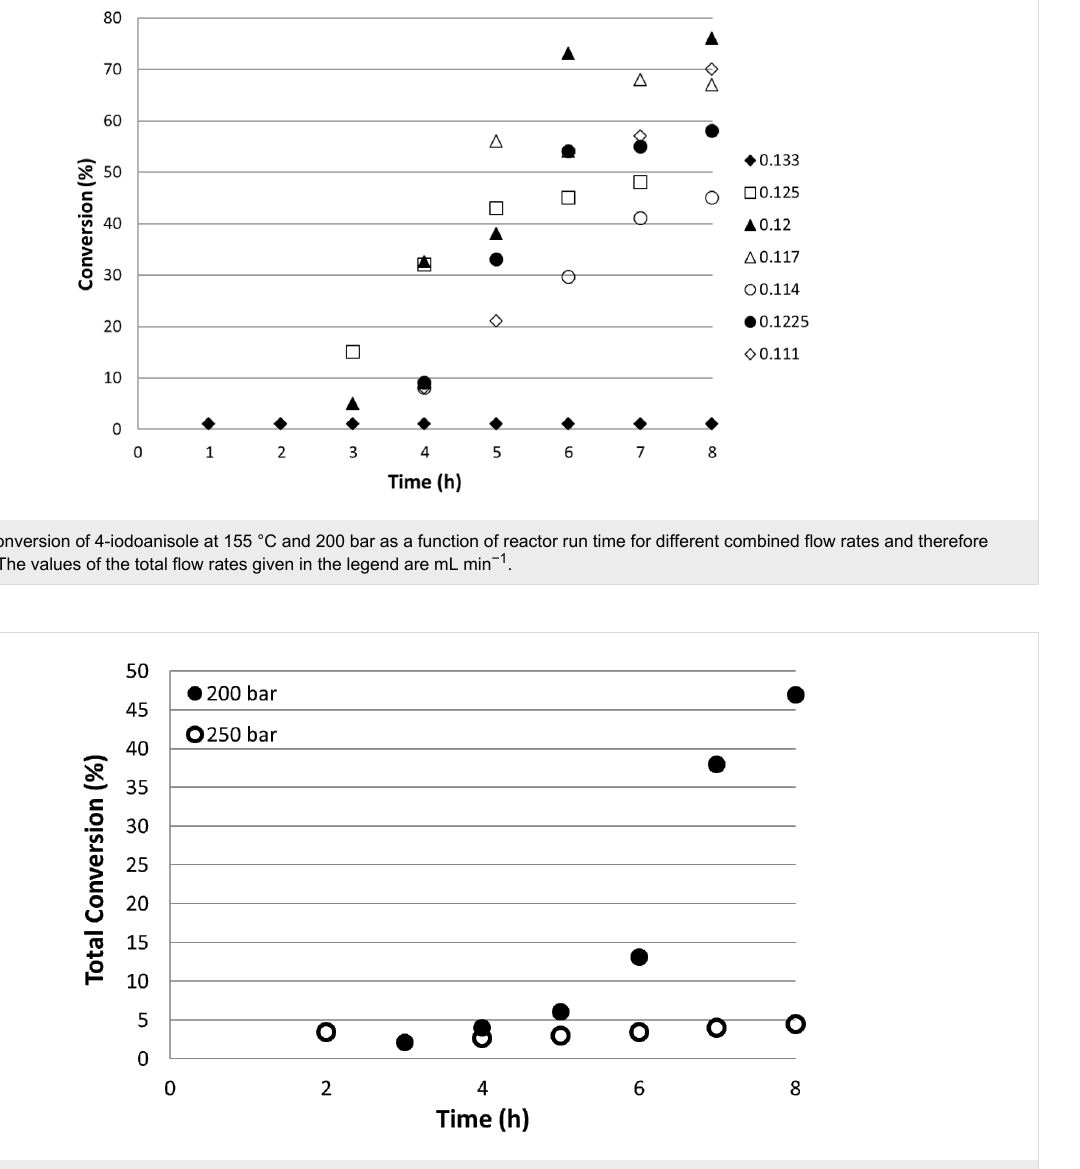
Figure 5: Total conversion of 4-iodoanisole as a function of reactor run time at 145 °C and at 200 ( ● ) and 250 ( ο ) bar CO 2